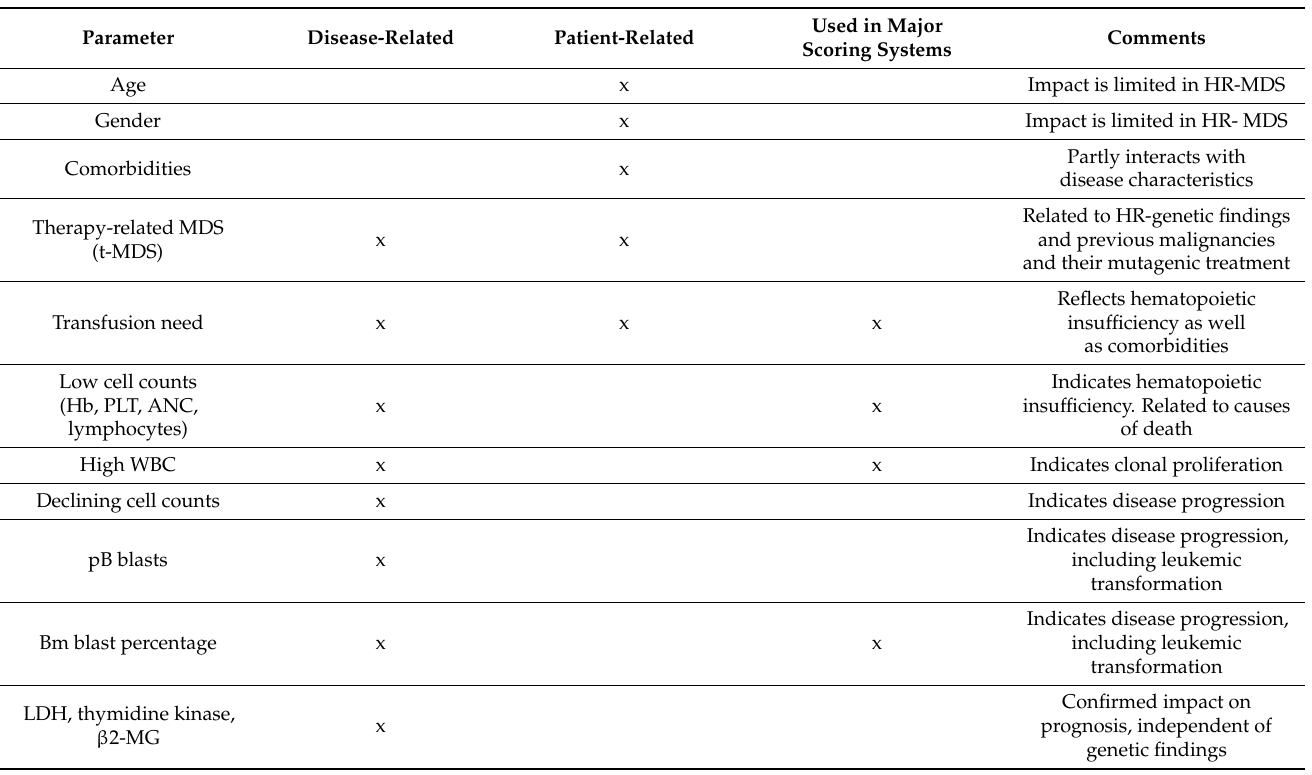
Table 1. Key prognostic parameters in patients with